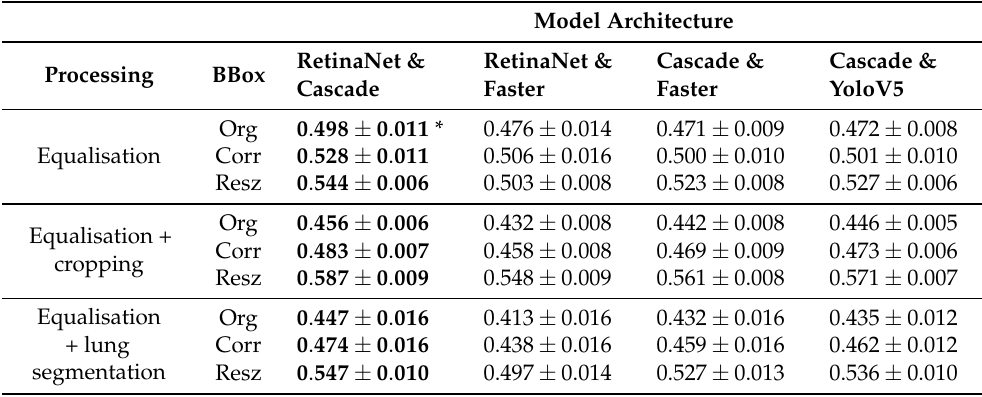
Table 3. Performance of the different model ensembles for different image pre-processing strategies and evaluation procedures. The BBox column has the same meaning as in Table